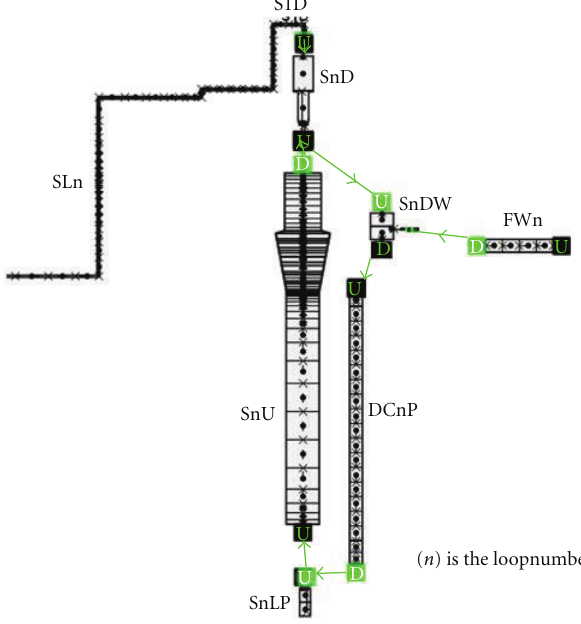
Figure 4: PKL secondary side view of the steam generator.